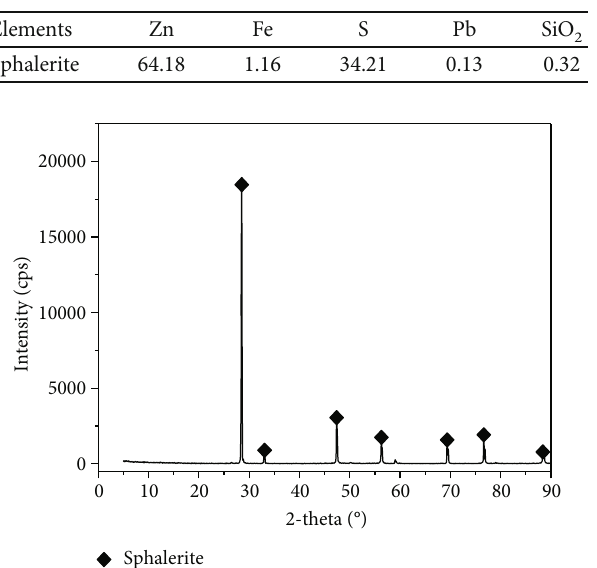
Table 1: Chemical compositions of sphalerite used in this study.